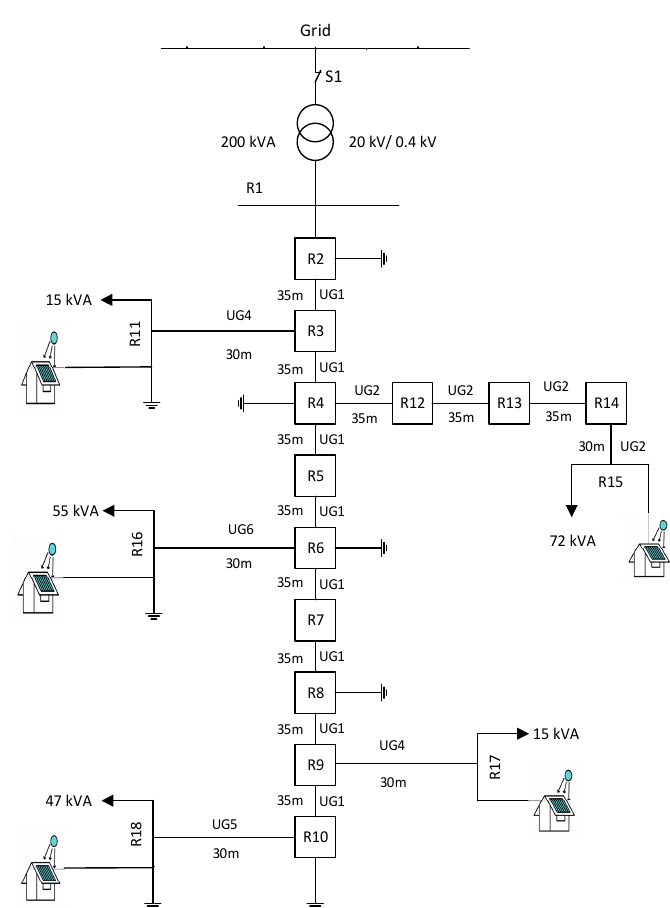
Figure 1. Single line diagram of the CIGRE underground residential low-voltage (LV) distribution network with photovoltaics (PV). Table 1. CIGRE LV distribution network: cable parameters.